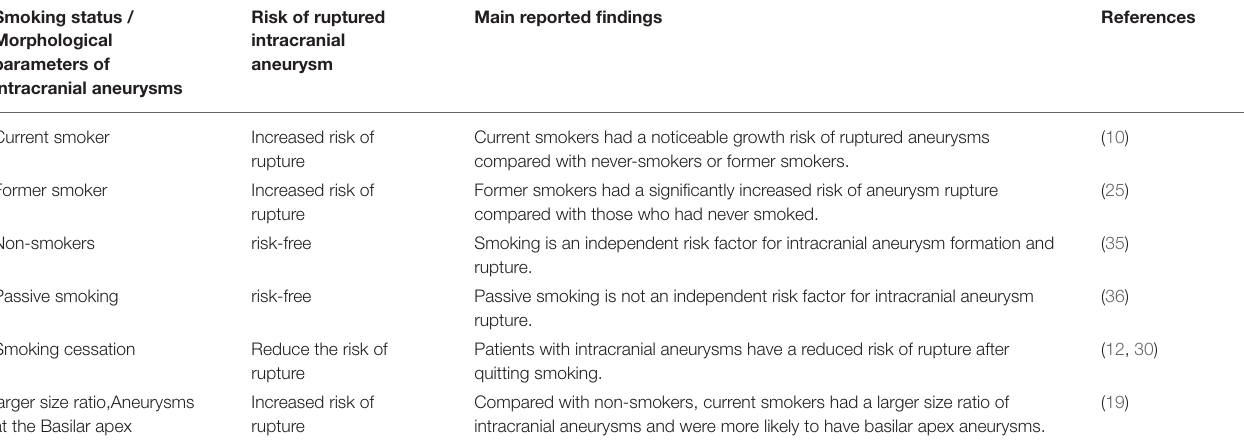
TABLE 3 | Relationship between smoking and intracranial aneurysm rupture and intracranial aneurysm morphology.